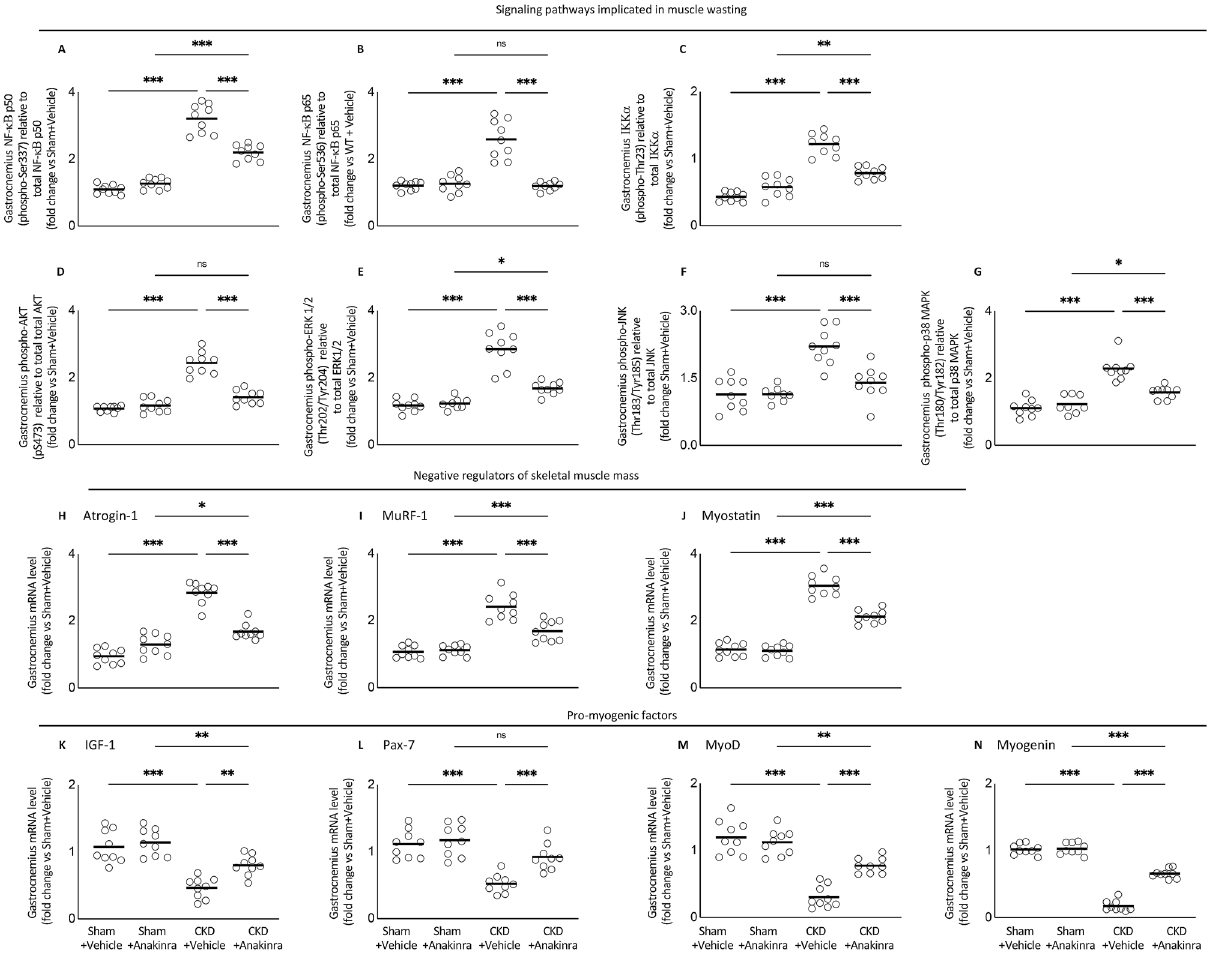
Figure 6. Anakinra attenuates signaling pathways implicated in muscle wasting in CKD mice. Gastrocnemius muscle relative phosphorylated NF-κB p50 (Ser337) / total p50 ratio ( A ), NF-κB p65 (Ser536) / total p65 ratio ( B ) and Iκκ α (Thr23) / total Iκκ α ratio ( C ) as well as muscle relative phospho-Akt (pS473) / total Akt ratio ( D ), ERK 1/2 (Thr202/Tyr204) / total ERK 1/2 ratio ( E ), JNK (Thr183/Tyr185) / total JNK ratio ( F ), p38 MAPK (Thr180/Tyr182) / total p38 MAPK ratio ( G ) in mice. In addition, gastrocnemius muscle expression of interested genes in mice was measured by qPCR. Transcriptional expression of negative regulators of skeletal muscle mass (Atrogin-1, MuRF-1 and Myostatin) ( H – J ) and pro-myogenic factors (IGF-1, Pax-7, MyoD and Myogenin) ( K – N ) were expressed in arbitrary units, with one unit being the mean level in WT/Sham + Vehicle mice. Results of WT/CKD + Vehicle were compared to WT/Sham + Vehicle and WT/CKD + Anakinra were compared to WT/Sham + Anakinra, respectively. In addition, results of WT/CKD + Anakinra were also compared to WT/CKD + Vehicle. * p < 0.05, ** p < 0.01, *** p <